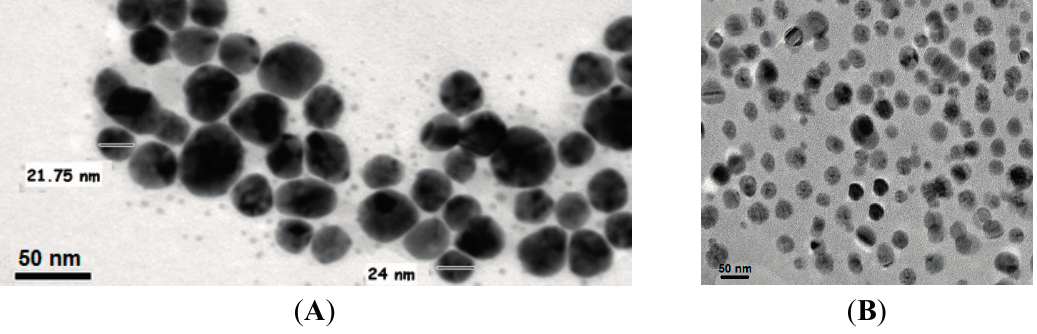
Figure 7. TEM micrographs of magnetite coated with ( A ) R-AN and ( B ) RK-AN